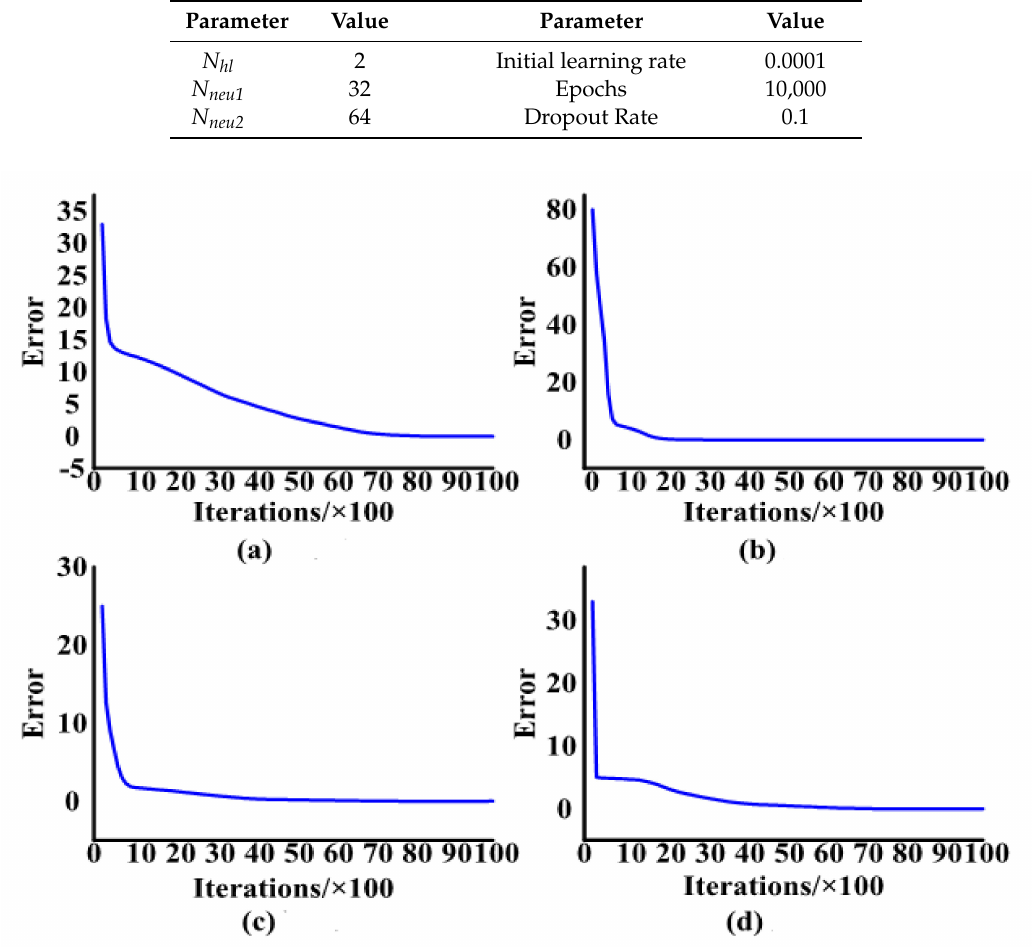
Figure 7. Network error tendency curve of EK-1 ( a ), AC ( b ), LAP ( c ) and EK-2 ( d